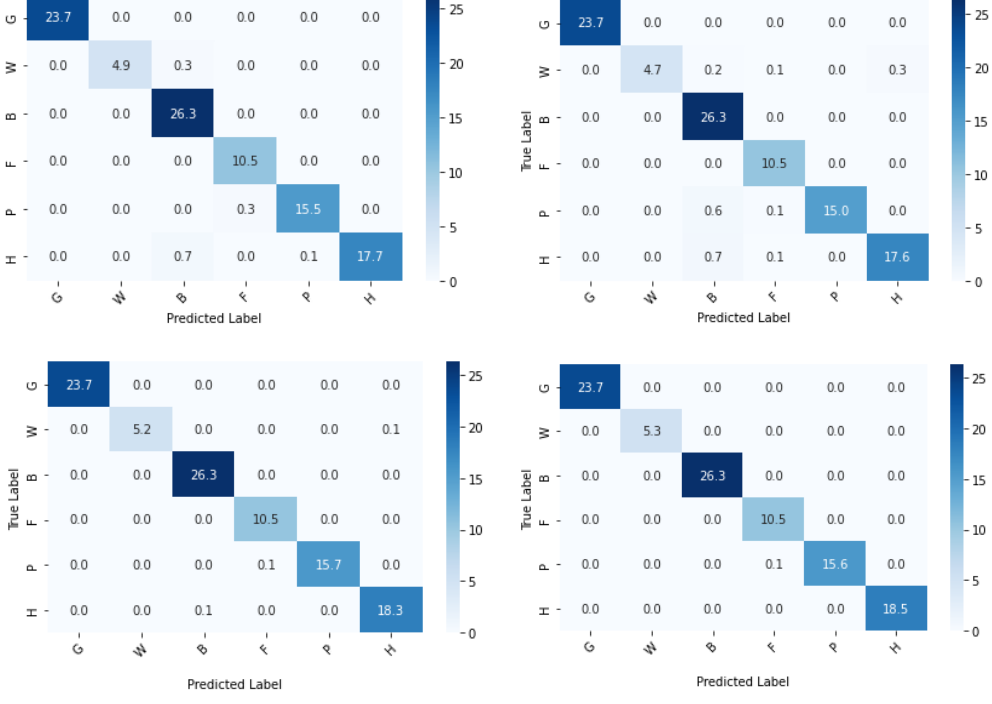
Figure 15. Confusion matrix (%) of base-learners with VGG16, Resnet34, MobilenetV2, and Ensemble models, respectively, for the reduced dataset.